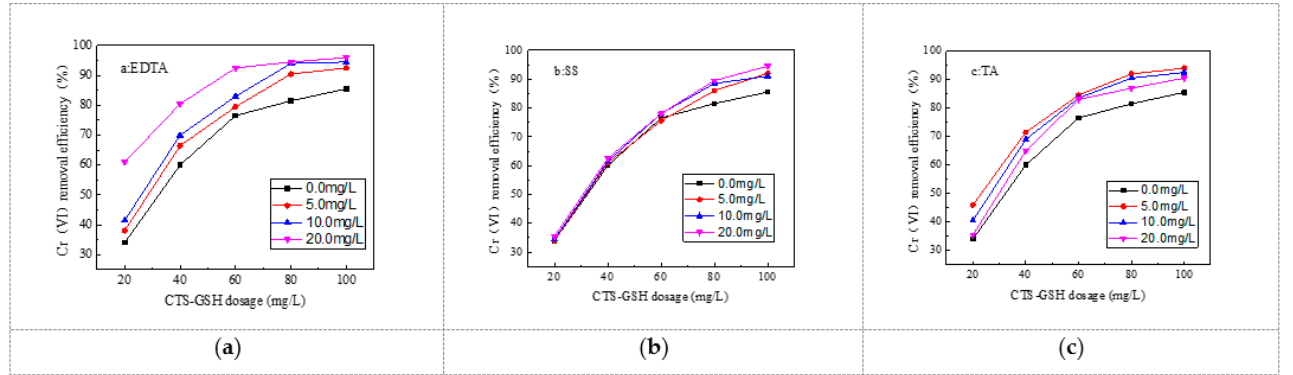
Figure 9. Effect of organic complexing agent on Cr(VI) removal. ( a ) Effect of EDTA on Cr( Ⅵ ) re- moval. ( b ) Effect of SS on Cr( Ⅵ ) removal. ( c ) Effect of TA on Cr( Ⅵ ) removal. ( b ) Effect of SS on Cr(VI) removal. ( c ) Effect of TA on Cr(VI)